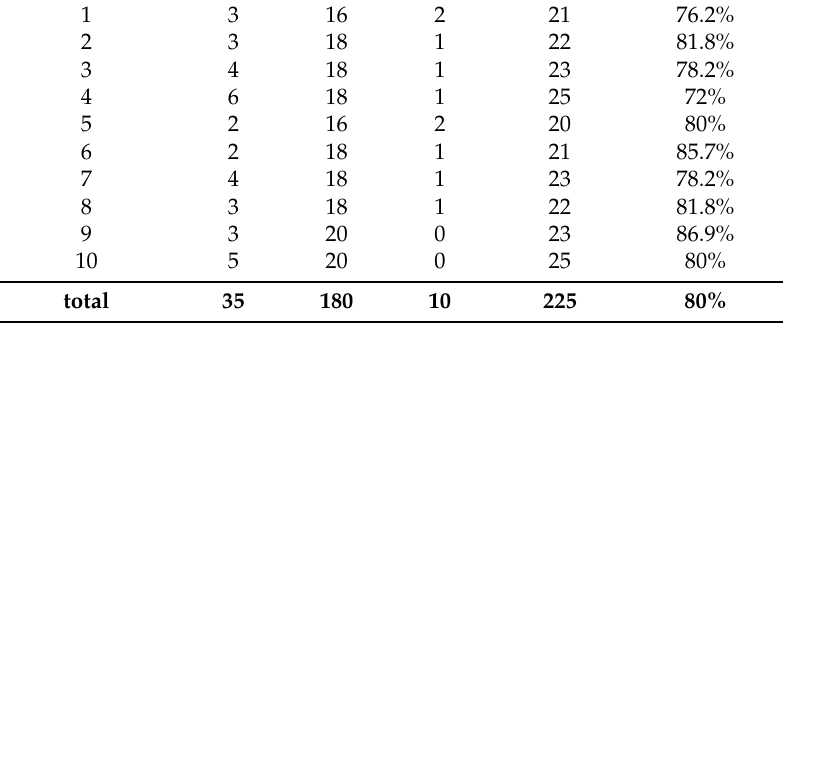
Table 1. Picking the white towels on the table (GN: the number of towels grasped). Experiment